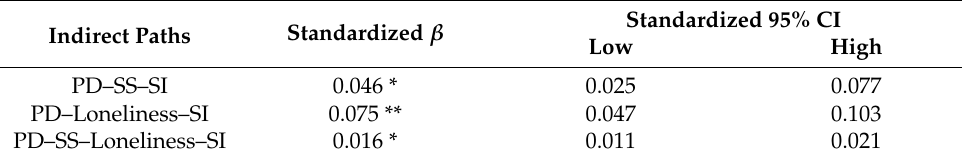
Table 3. Bias-corrected bootstrap text on mediating effects.